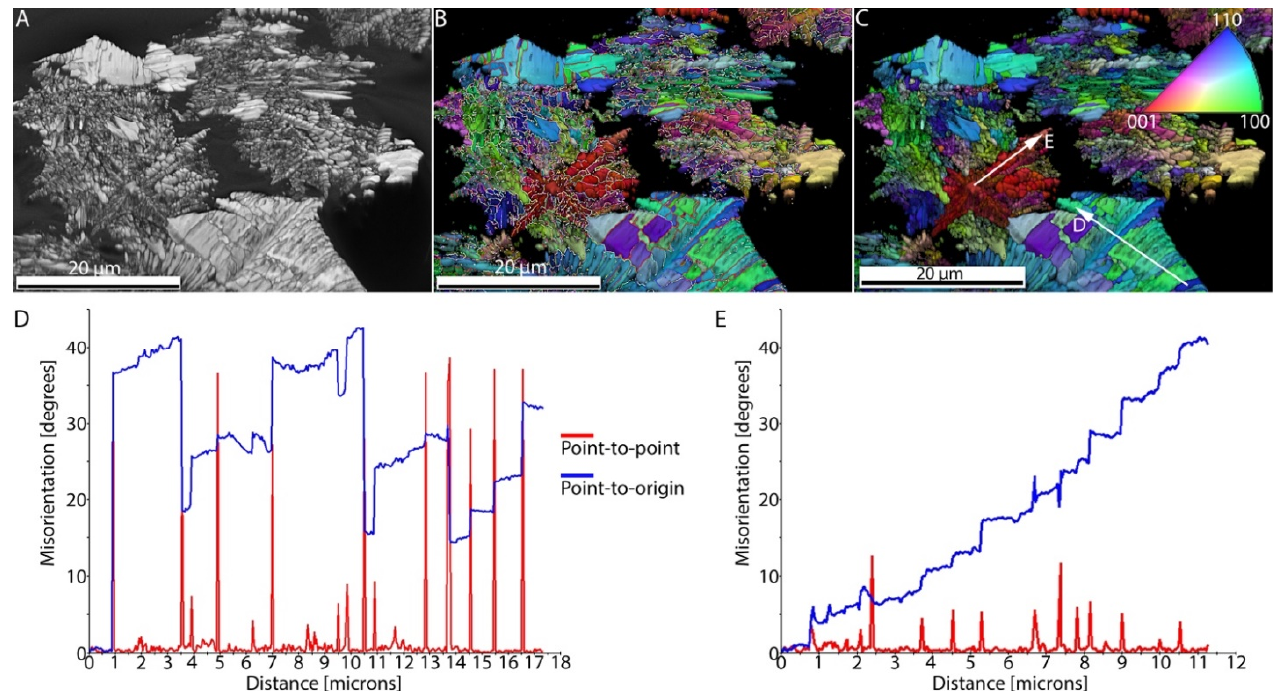
Figure 11. High-resolution EBSD data of a sample heat-treated in argon. ( A ) Image quality. ( B ) Grain boundaries are color-coded to show the axis of relative rotation between neighboring grains, using the same color coding as the IPF. ( C ) 001 inverse pole figure mapping with traces of the misorientation profiles. ( D ) + ( E ) Misorientation profiles along arrows ( D , E ) in Figure